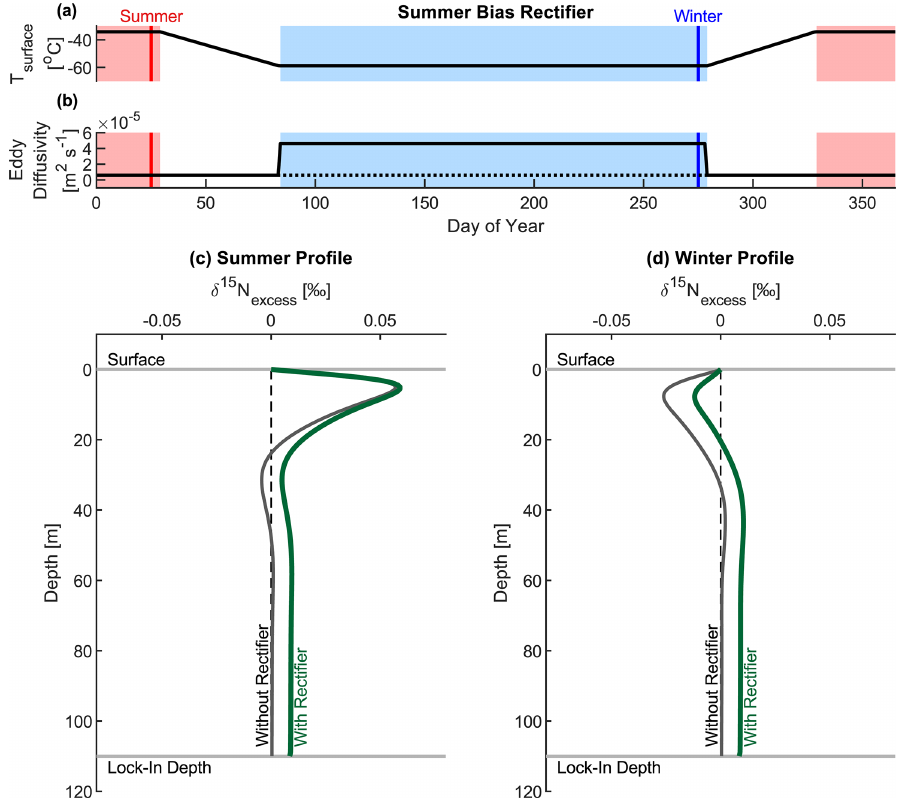
Figure 10. As in Fig. 8, panel (a) shows the temperature forcing and panel (b) shows the eddy diffusivity forcing applied to the firn air model. The solid lines correspond to the “with rectifier” run, and the dotted line in (b) corresponds to the “without rectifier” run with no seasonal change in eddy diffusivity. Panels (c) and (d) show the vertical profile of δ 15 N excess in the firn column at the end of summer and winter respectively. The grey line is the run without advection, and the green line is with advection. The days corresponding to the profiles are indicated by the vertical lines in the upper panels. An animated version of this figure is available in the Supplement as Movie